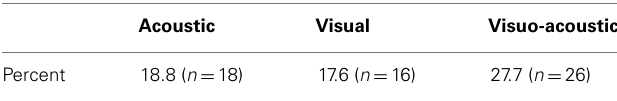
Table 3 | Proportion of neurons expressing two different patterns per sensory